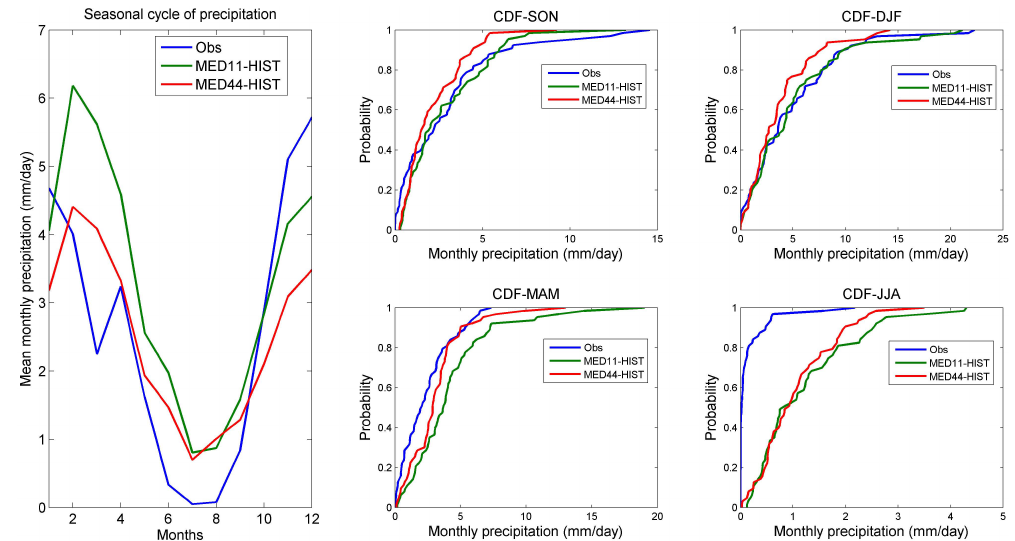
Fig. 5. Evaluation of the seasonal cycle (left panel) and seasonal distributions of monthly precipitation (right panels) of MED11-HIST and MED44-HIST